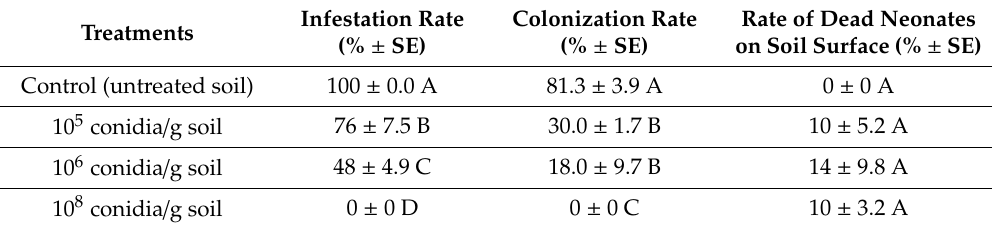
Table 3. Infestation, colonization, and dead individual rates of C. tenebrionis larvae in untreated soil (control) and Mb7-GFP treatments with increasing doses of conidia.